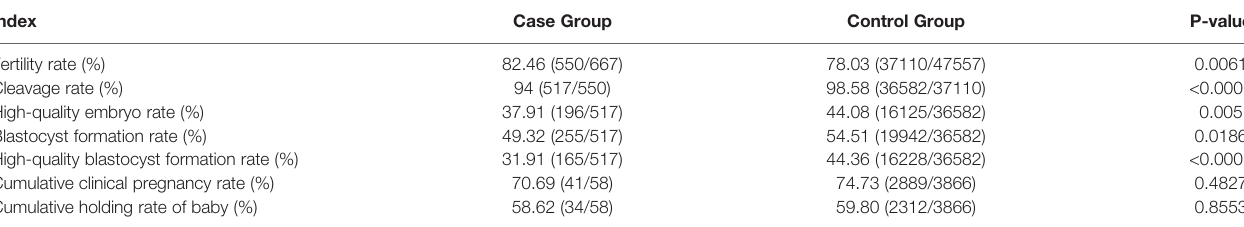
TABLE 2 | The results of early development and clinical treatment in the patients ’ oocytes with agar-like and normal